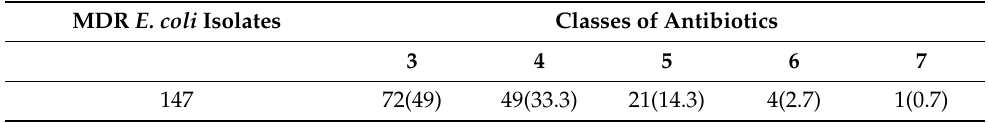
Table 2. Classes of antimicrobial patterns resisted n (%).